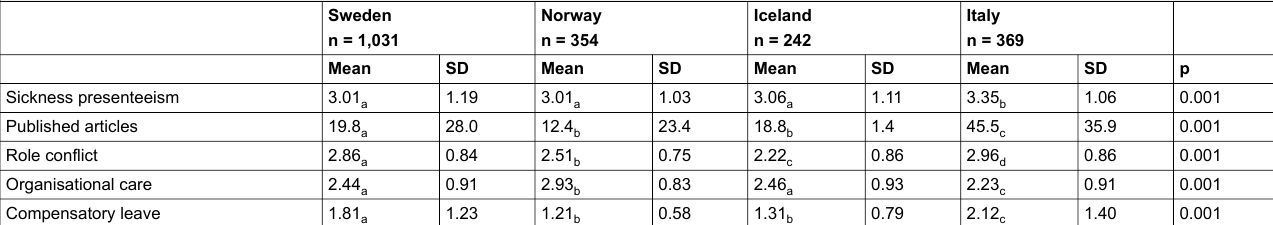
Table 1: Description of demographic characteristics and included variables among university hospital physicians from Sweden, Norway, Iceland and Italy. Sweden n = 1,031